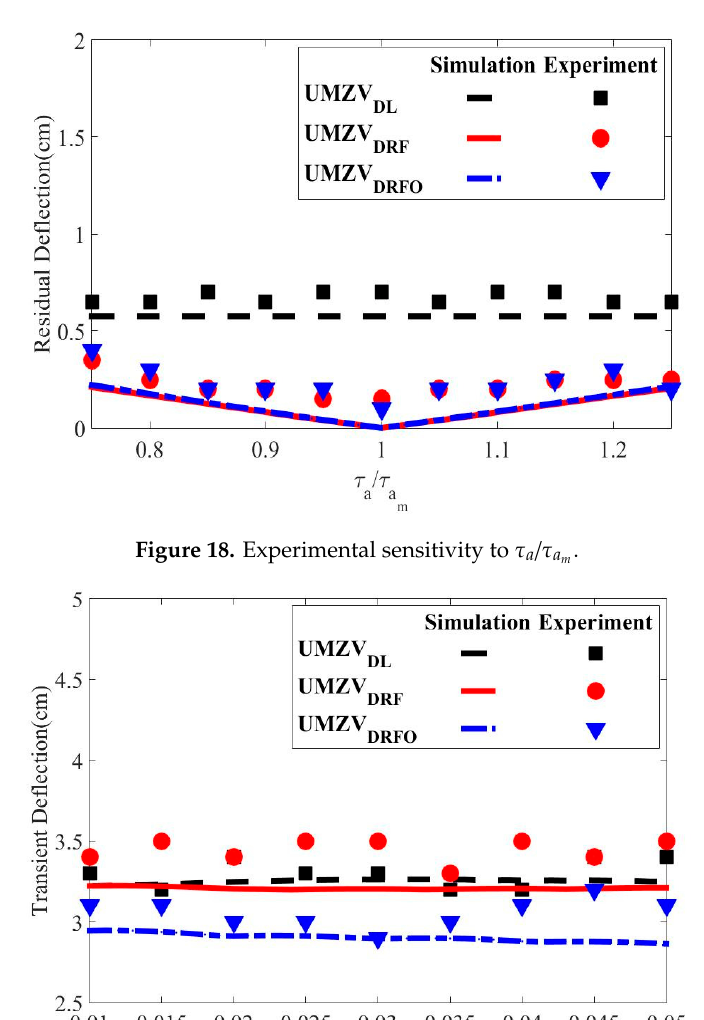
Figure 17. Experimental sensitivity to L/L m .